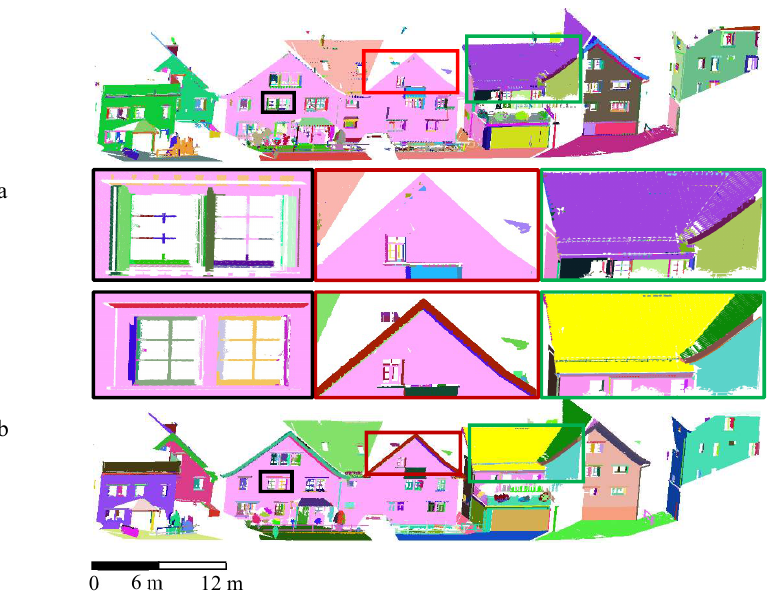
Figure 10. Details of result comparison of terrestrial laser scanner data. ( a ) Details of segmentation results of VGS, and ( b ) details of segmentation results of the EVBS algorithm. Table 2. Plane segmentation evaluation results of experiments using terrestrial laser scanner data.